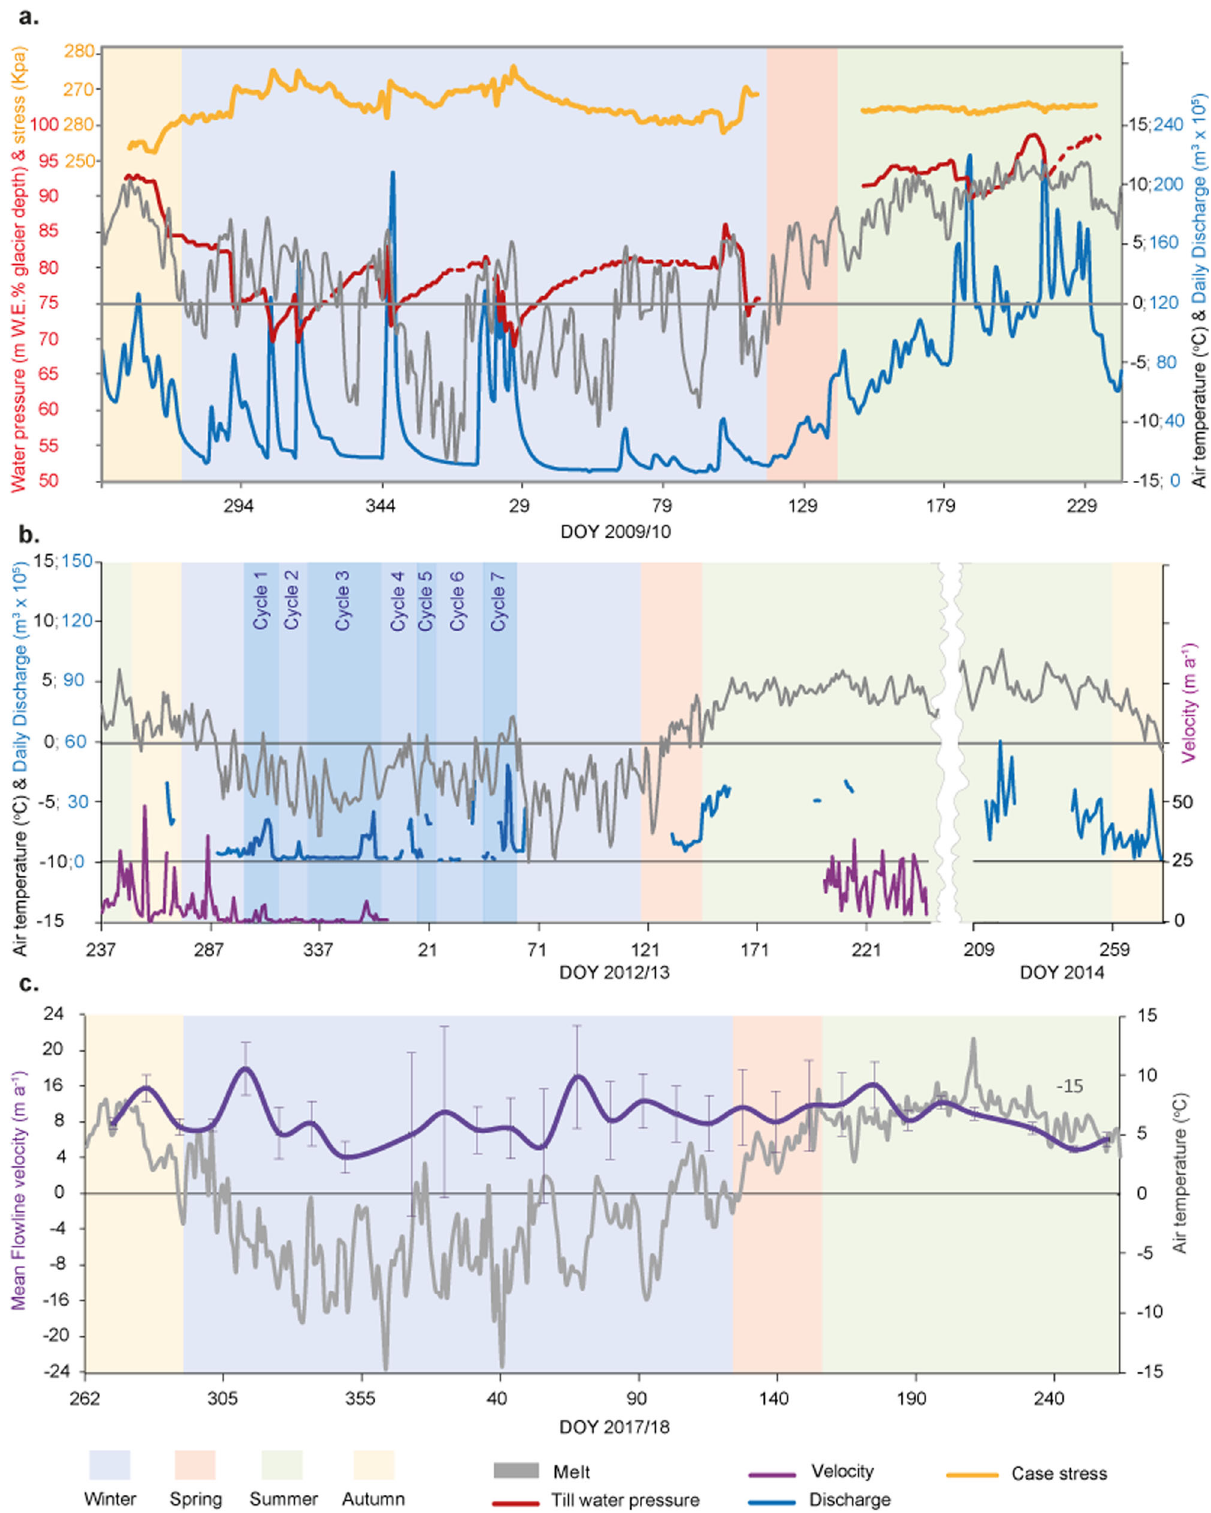
Fig. 2 Long-term records. a Skálafellsjökull north — Till water pressure, case stress, daily discharge from the component of the Kolgríma river from this part of the glacier (see the ‘ Discharge ’ section in ‘ Methods ’ for detail) and daily air temperature — 2009/10. b Sultartungnajökull catchment — mean horizontal surface velocity, daily discharge (Sta đ ará river) and daily air temperatures — 2009/10. c Skálafellsjökull — mean velocity along the fl owline (Sentinel-1 Remote sensed data) and daily air temperature 2017/18. Calculation of error explained in ‘ Methods ’ , in the ‘ Measurements of ice velocity ’ section. All daily air temperatures from the base station, DOY = day of